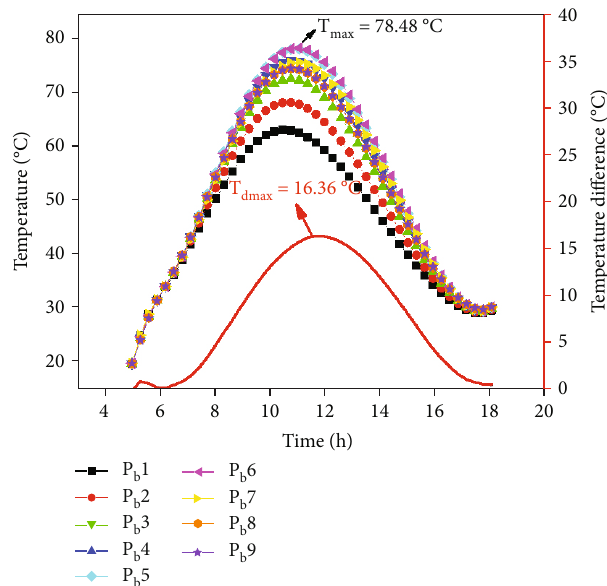
Figure 11: Temperature variations of battery in H –